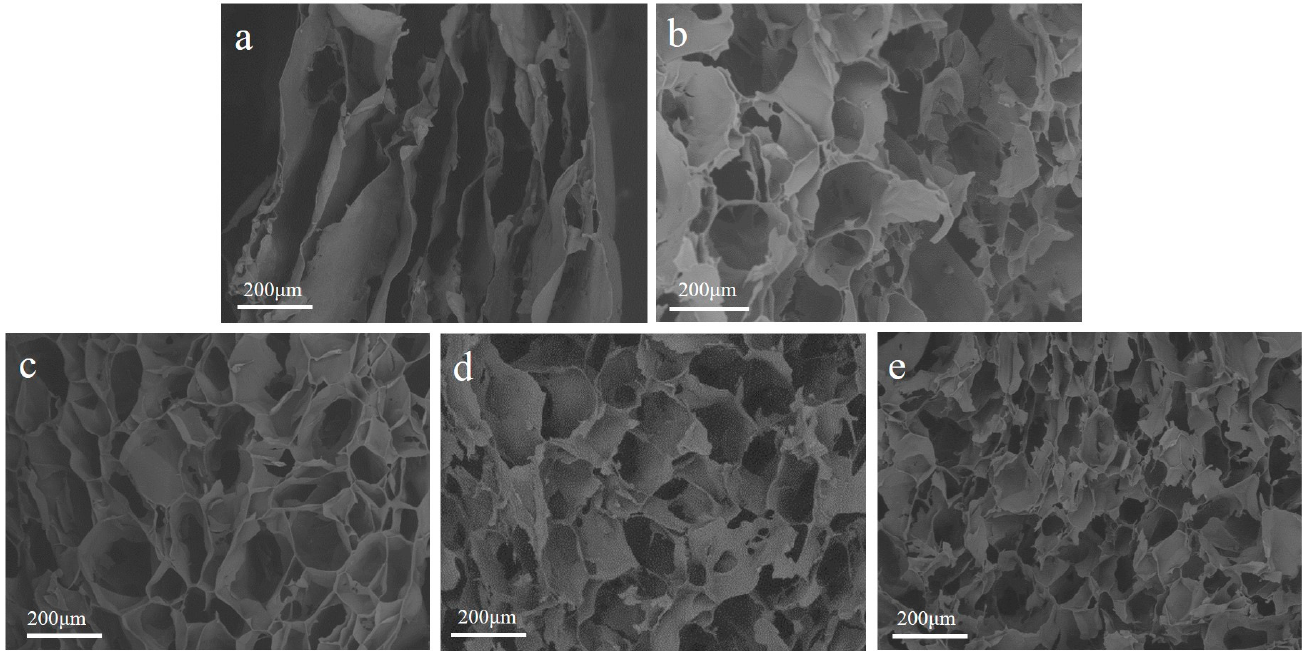
Figure 3. The SEM graphics of freeze-dried ( a ) CMCS hydrogel, ( b ) SS/CMCS hydrogel, and samples ( c ) SC850, ( d ) SC950, and ( e ) SC1050. Table 2. The average pore sizes of SS/CMCS hydrogel, SC850, SC950 and SC1050. Samples Pore Size ( µ m) SS/CMCS